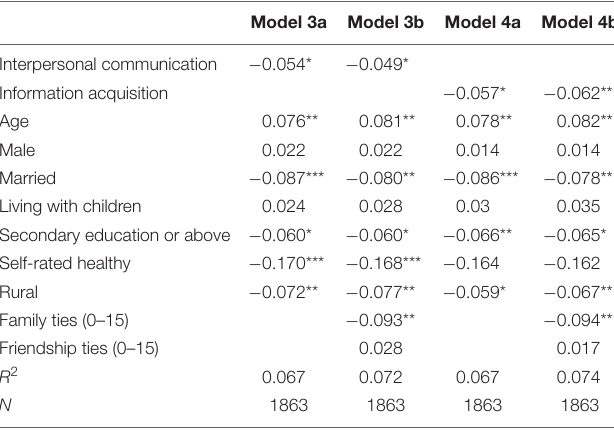
TABLE 3 | Loneliness regressed on Internet use ( β